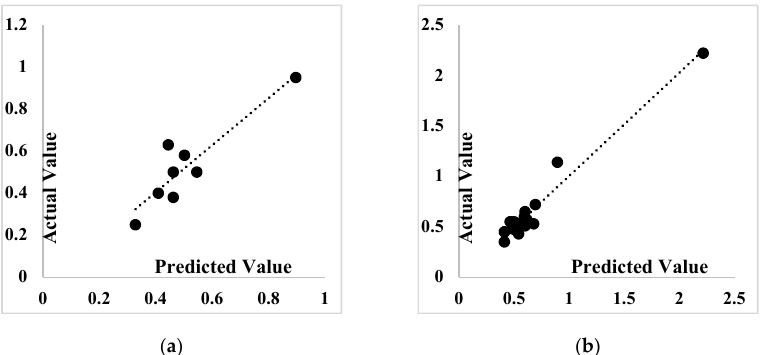
Figure 12. Scatter plot of the SP demand prediction for ANFIS-PSO: ( a ) Testing phase ( b ) Training phase.